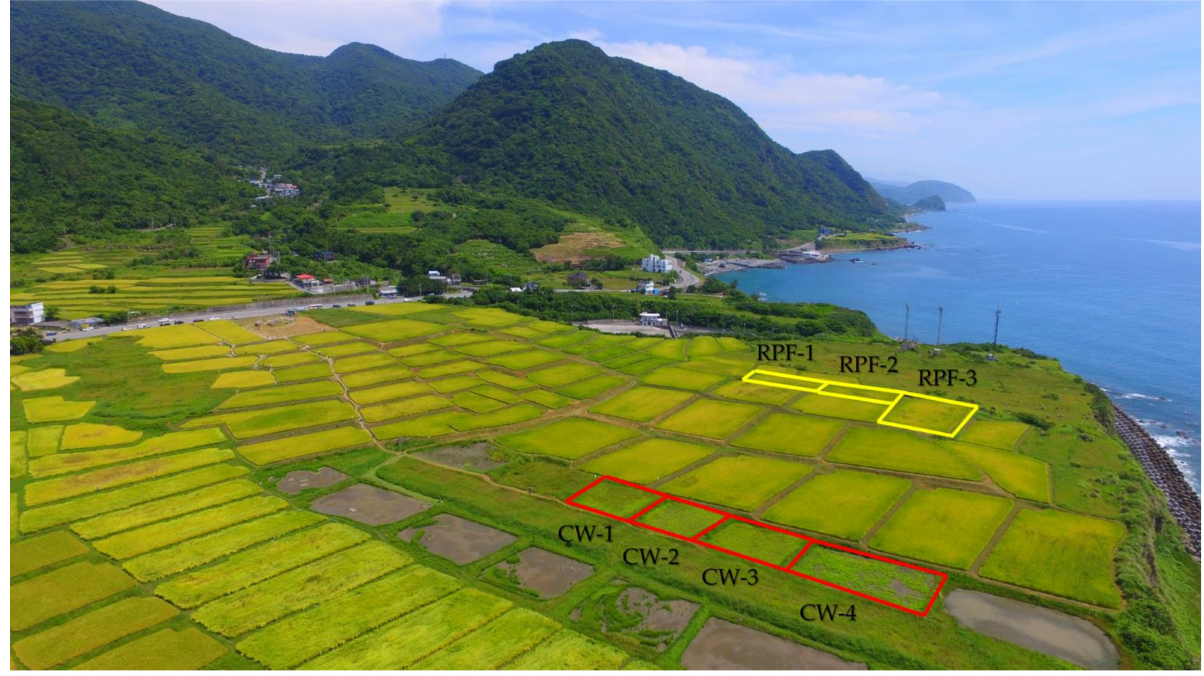
Figure 2. The aerial photo of the study site, the plots of CW treatment are framed in red lines, and the plots of RPF treatment are framed in yellow